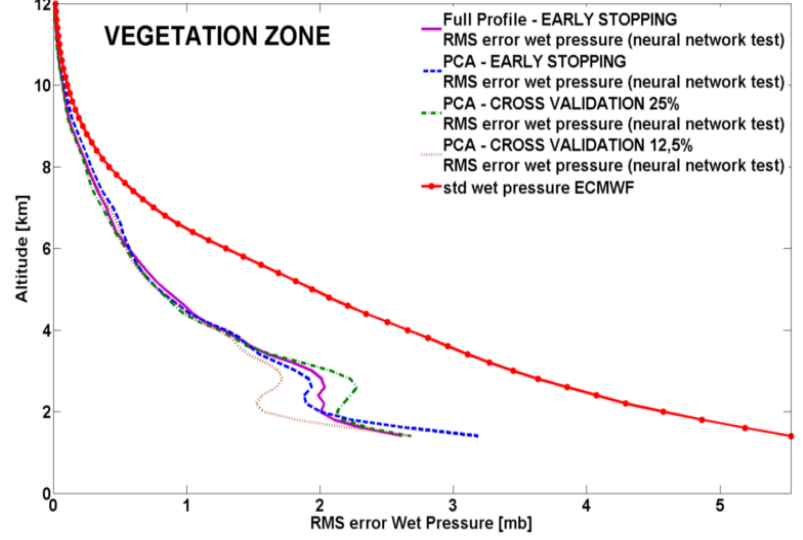
Figure 7. Vegetation zone, neural network independent test (35 occultations): RMS error profiles for P using the different neural network w